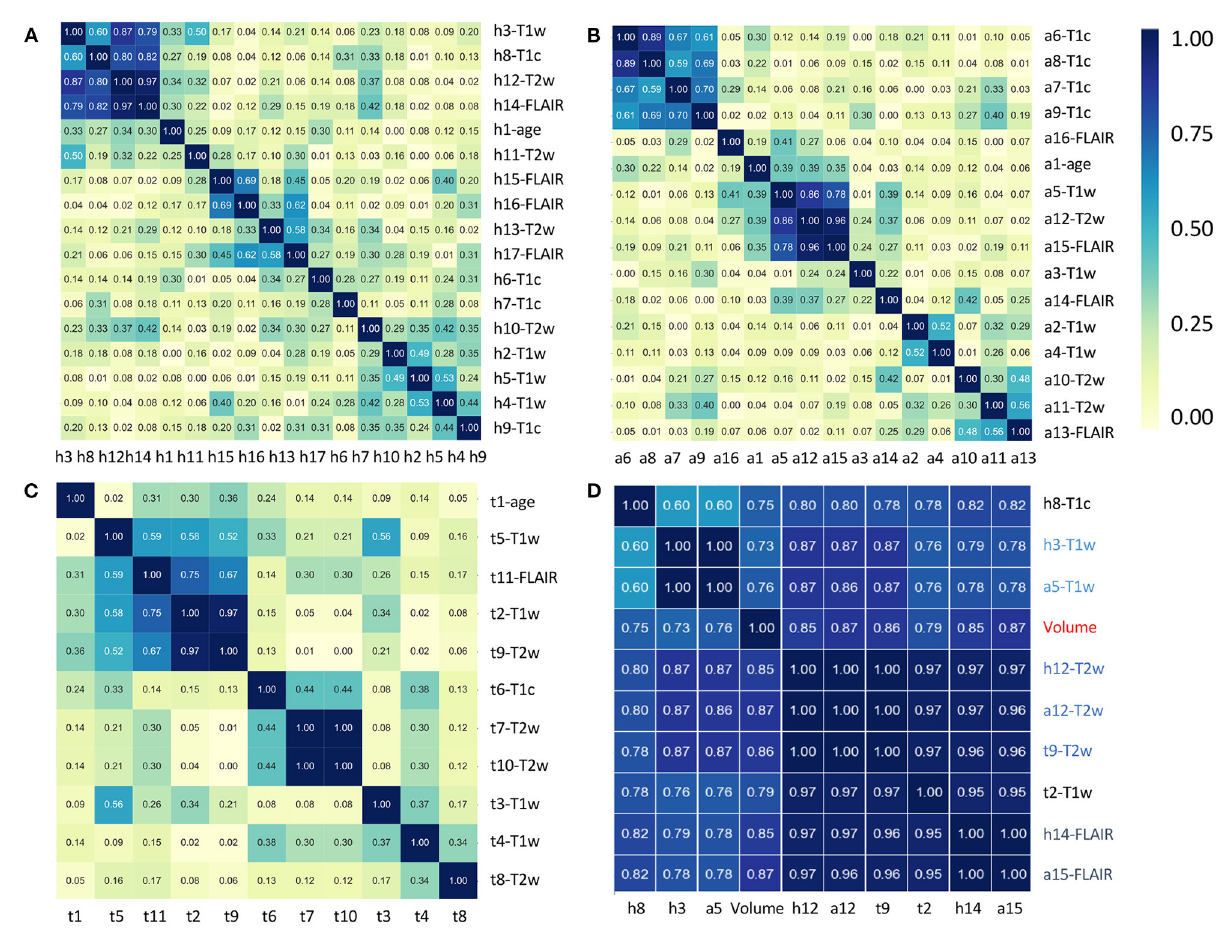
FIGURE4 Correlation heatmaps between the features that have been selected by the five different models to predict H3.1 mutation (A) , ACVR1 mutation (B) , and TP53 mutation (C) . Tables 3–5 provide correspondence between feature identifiers and the full feature name according to PyRadiomics nomenclature. In (D) , correlation matrix heatmap between the previously selected features which are highly correlated with tumor volume. Feature identifiers (on the right side) of identical features found by the different predictive tasks are shown in color.